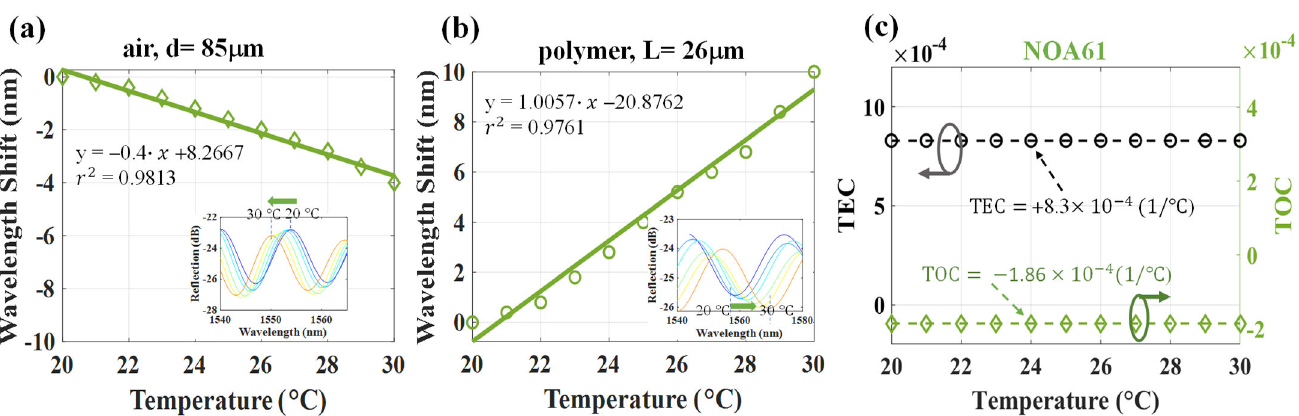
Figure 5. Wavelength shifts from 20 ◦ C to 30 ◦ C for the cavities of ( a ) air, ∆ λ a , and ( b ) NOA61-polymer, ∆ λ p ; ( c ) measured TEC and TOC from the results of ( a , b ). When the DCFFPI was heated by the TE cooler, the wavelength shifts per ◦ C of the air ( ∆ λ a ) and polymer ( ∆ λ p ) cavities could be respectively estimated by using the following simultaneous Equations (1) and